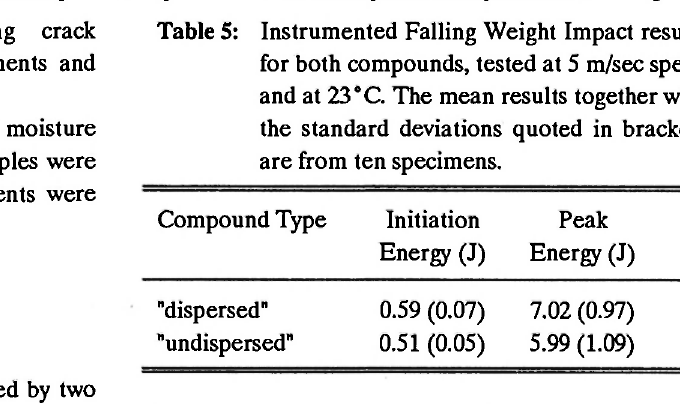
Table 5: Instrumented Falling Weight Impact results for both compounds, tested at 5 m/sec speed and at 23° C. The mean results together with the standard deviations quoted in brackets are from ten